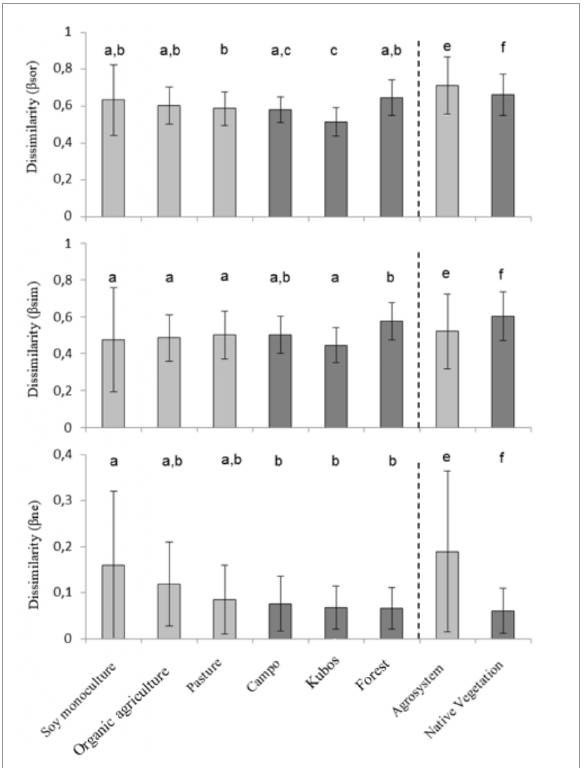
Figure 11: Values of beta diversity based on data of presence and absence of ant species collected using pitfall traps between June 2019 and August 2020 in the Rashad District. β sor represents the sum of β sim and β nes.